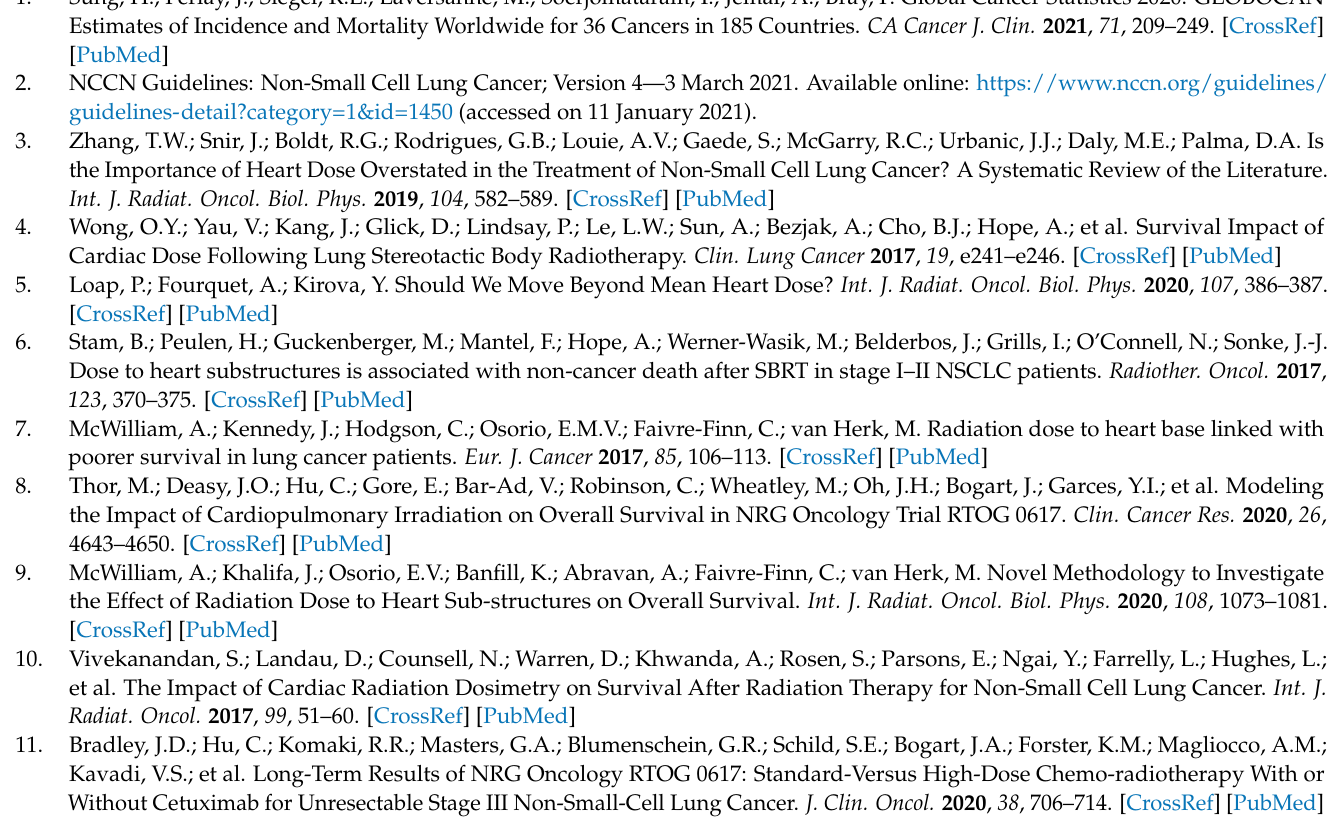
tion; Table S2: Univariate Cox regression for overall survival; Table S3: Multivariate analysis with Ultracentral tumor